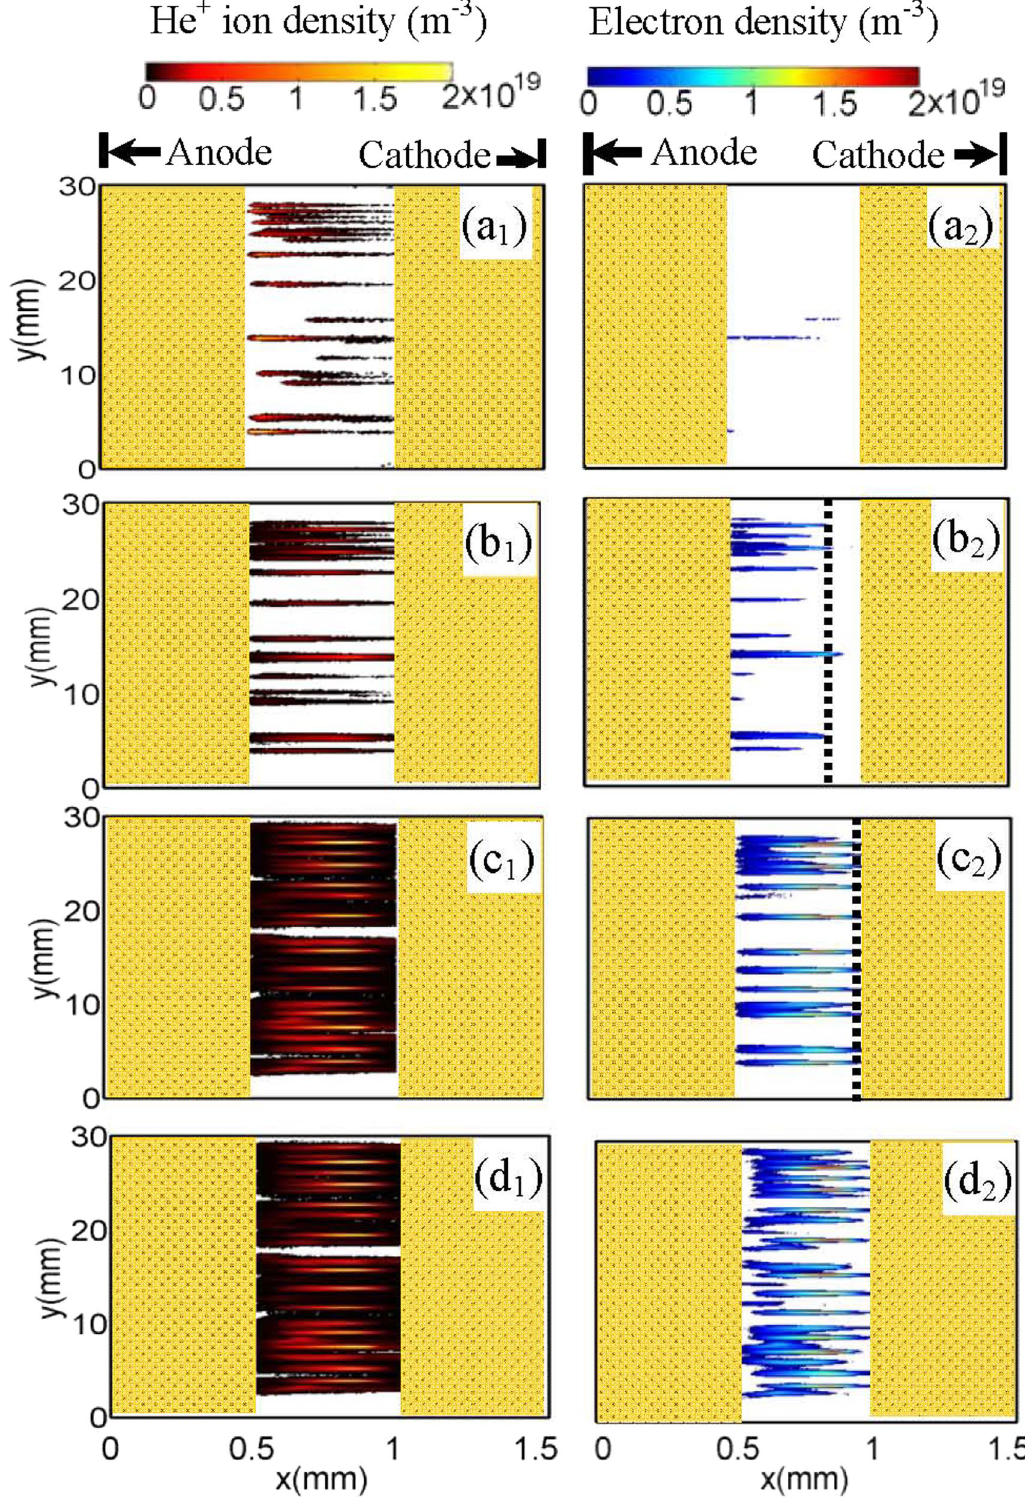
Figure 3. Time evolution of filamentary discharges in DBD. The axes (Anode and Cathode) denote the surfaces of metal electrodes. The values of densities displayed in ( a 1 ) and ( a 2 ) have been multiplied by a factor of 16. The dashed lines in ( b 2 ) and ( c 2 ) show the edges of the transient plasma